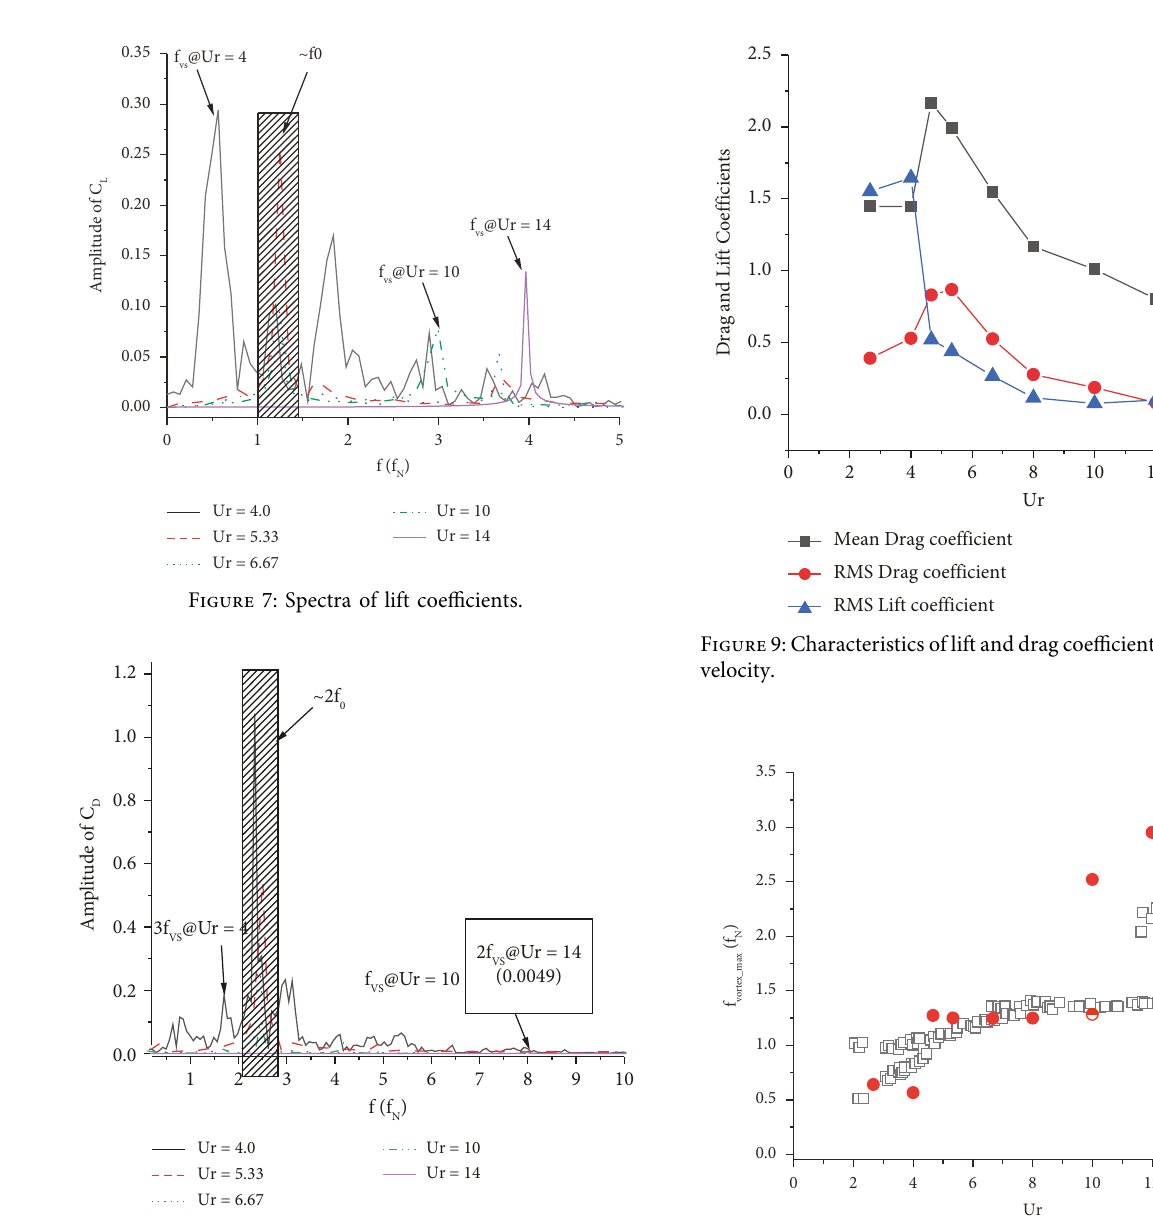
Figure 8: Spectra of drag coefficients.